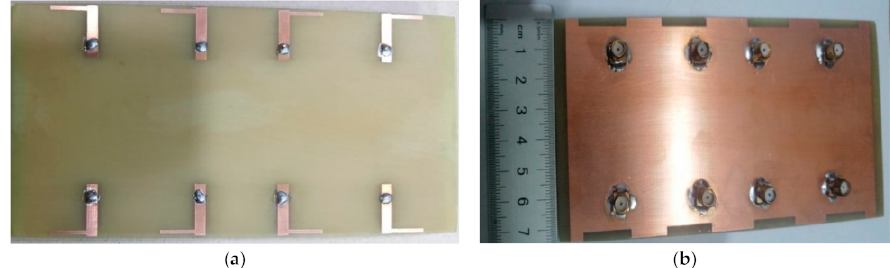
Figure 5. Proposed Dual band antenna fabricated prototype. ( a ) Front ( b )